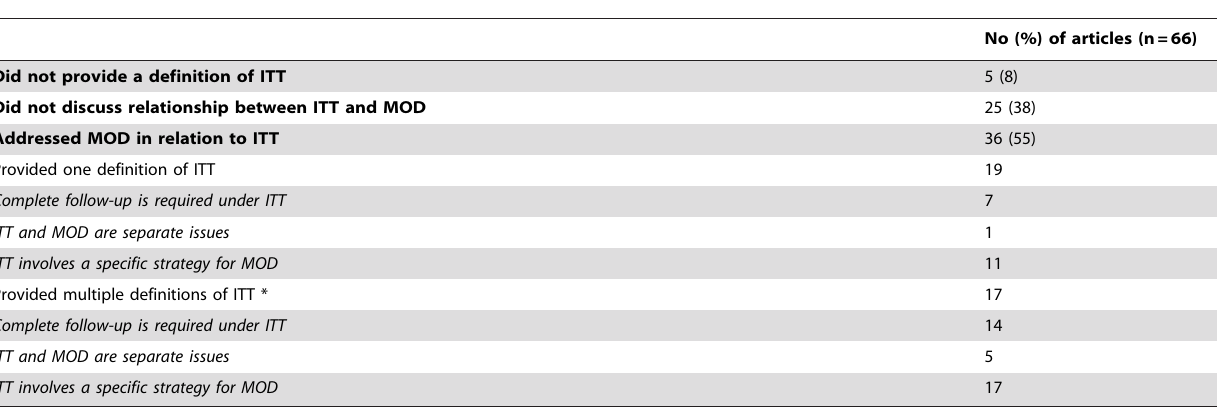
Table 1. Definitions of intention to treat (ITT) in relation to missing outcome data (MOD).